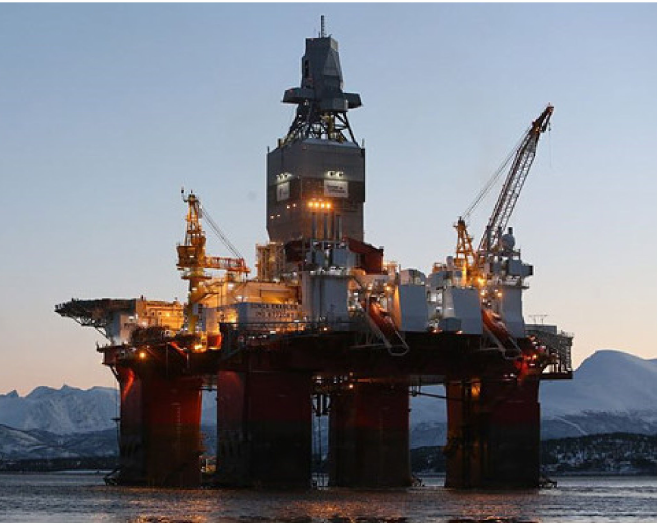
Figure 4. Transocean Enabler semi-submersible drilling rig built in 2016 and designed to operate in harsh environments (Courtesy: